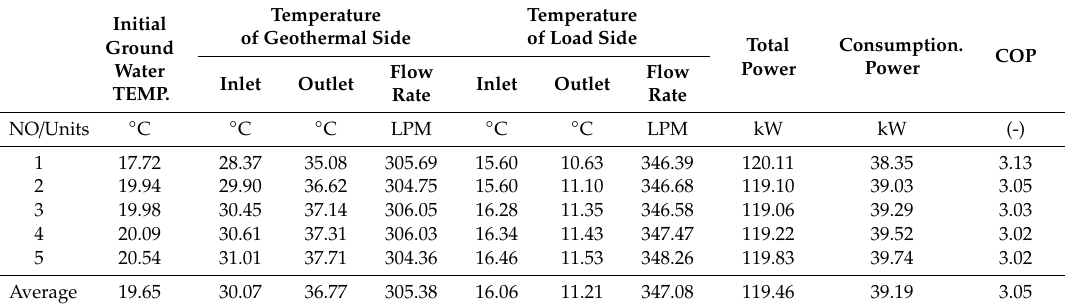
Table 3. Measured results of the SCW geothermal system cooling operation.